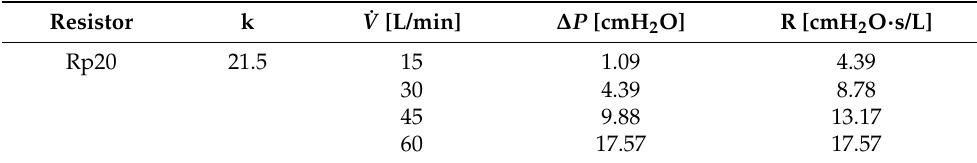
Table 1. Calculated pressure drop ∆ P and equivalent linear airway resistance (R) values for flow rates in the measurement region for the used parabolic resistor Rp20. Resistor